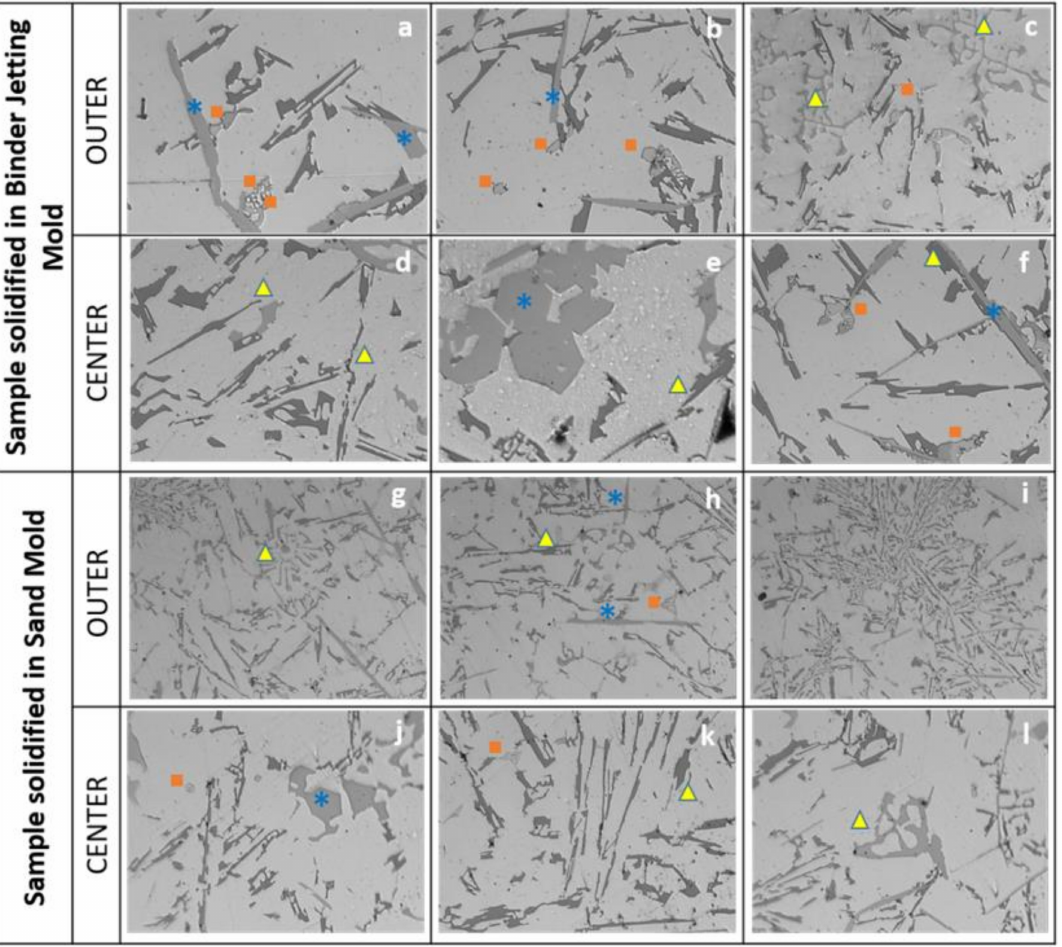
Figure 2. Optical micrographs of the samples: obtained in the outer area ( a – c ) from binder jetting mold and ( g – i ) from sand mold, and obtained in the center area ( d – f ) from binder jetting mold and ( j – l ) from sand mold. Si phase; Al 2 Cu phase; Al-Fe-Si